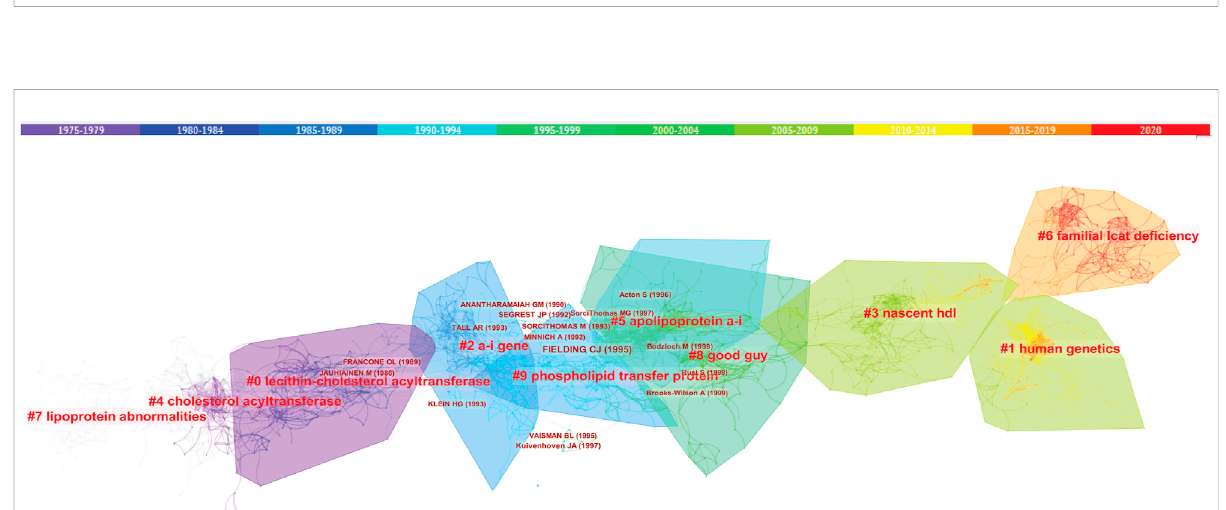
FIGURE 7 The network of co-cited references clusters. Clusters are labeled in bright red. Key authors are labeled in dark red. The clusters labels and key authors ’ labels are located in different outlines with different colors, and the warmer the colors, the closer they are to the latest current. Clusters within the red outline indicate the current research hotspots, that is, rapid increases in citation counts. #, a cluster; hdl, high density